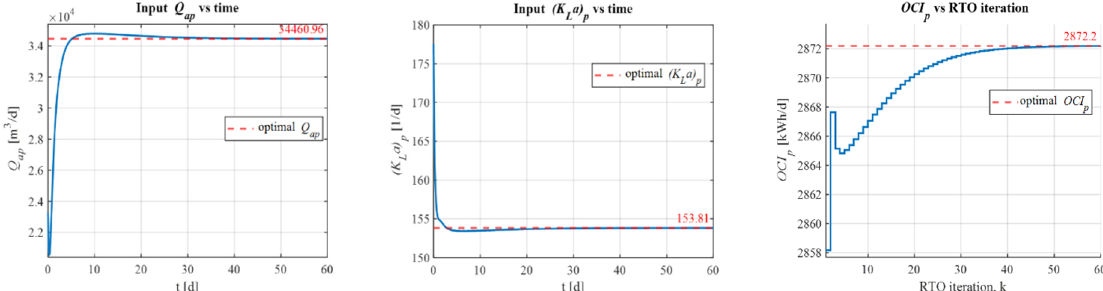
Figure 7. Fast CA results–Plant inputs and overall cost index.